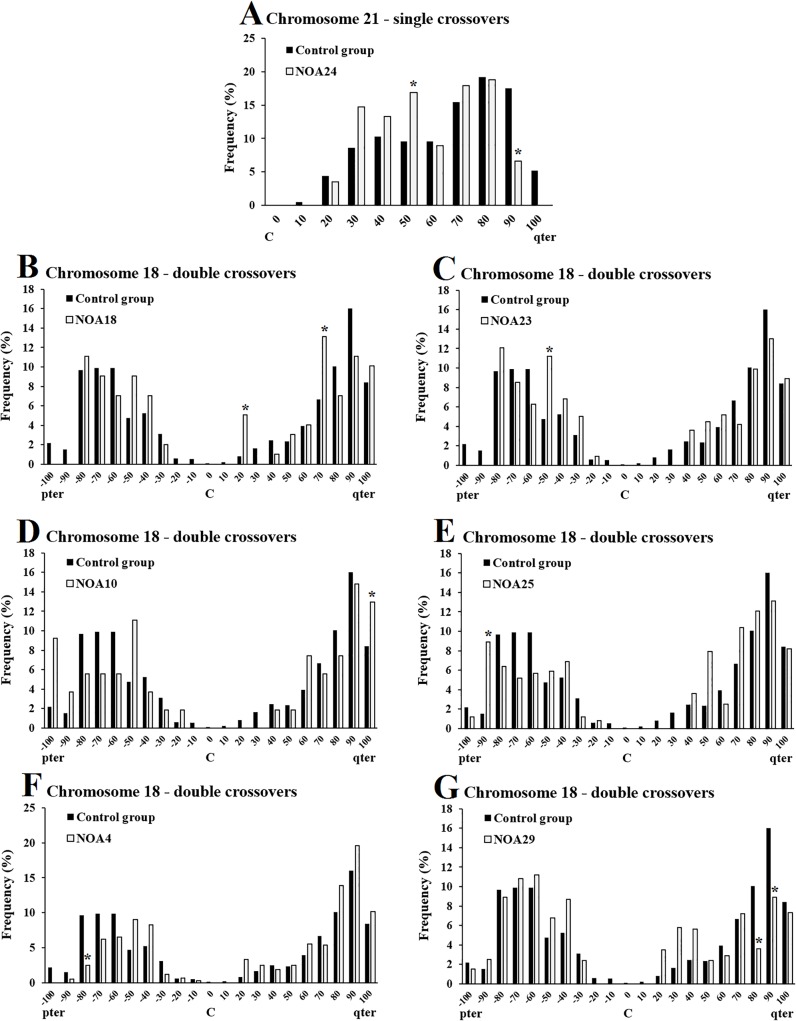
Chromosomes 21 and 18 displaying altered crossover distributions in NOA men.Chromosome arms were divided into 10% intervals, and the crossover frequency in each interval was calculated. The Y-axis represents the frequency of crossovers in each interval. The X-axis represents the relative crossover position from the centromere with the values representing the upper limit of each interval. The centromere is labeled ‘C’ with the p-arm to the left and q-arm to the right. As crossovers in the p-arm of chromosome 21 are extremely rare, the p-arm is not shown. The black bars indicate the control group and the white bars indicate the individual NOA man. The crossover frequencies in each interval were compared to the control group and significant differences are indicated by asterisks (P < 0.05, Fisher test).